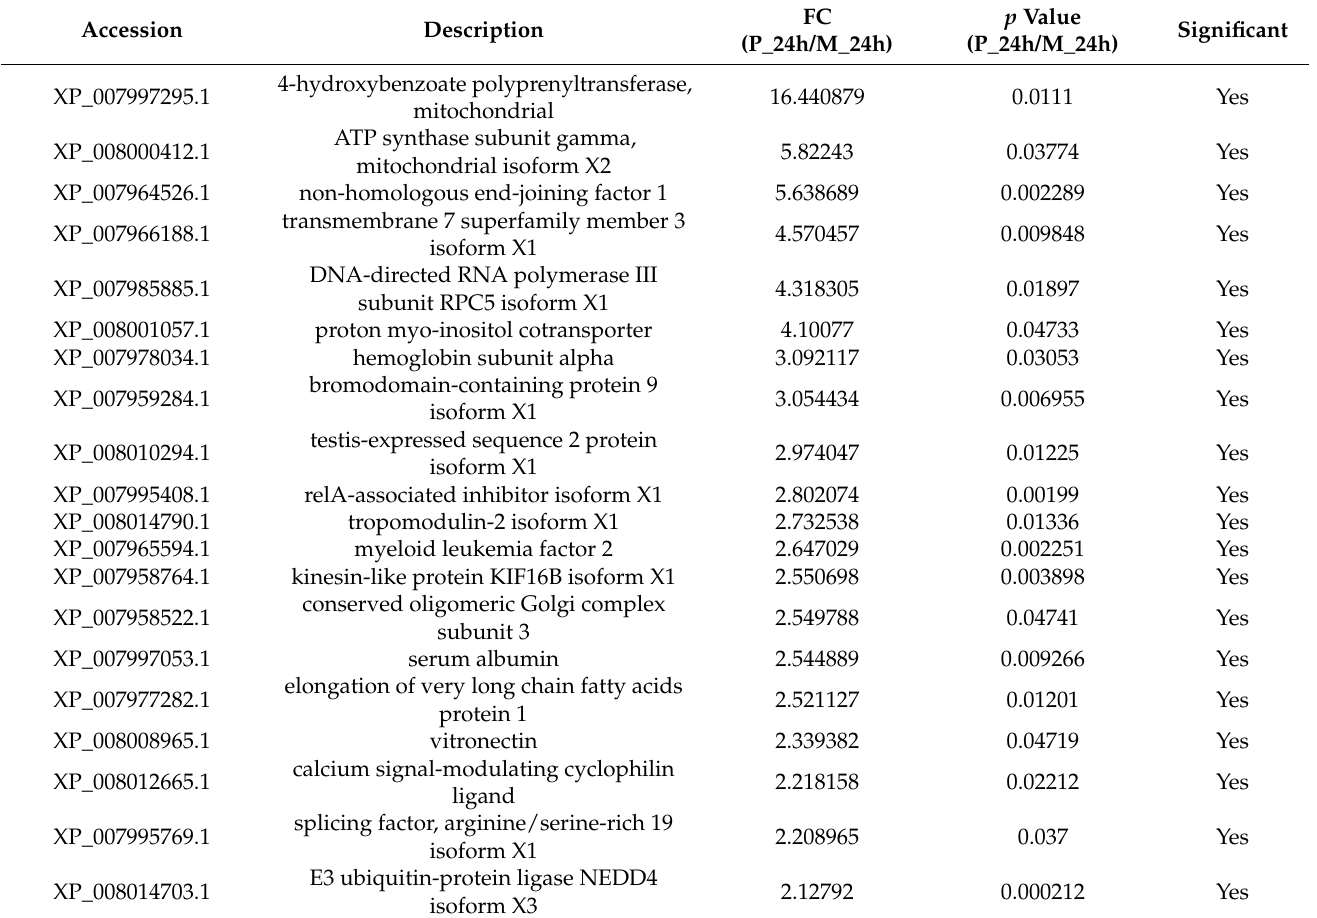
Table 2. Top 20 up-regulated